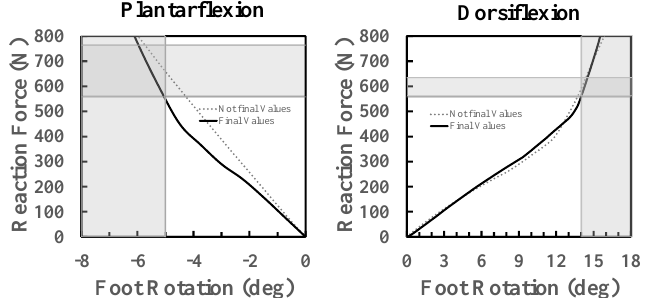
Figure 21. Results from the first stage of the design phase . The results from the pre-optimized configuration (Table 3) are compared to the results of a random configuration. The vertical shadow is the rotation range that the foot must have (values defined and specified in Section 2.4, “Biomechanical Requirements”, i.e., between − 5 degrees and − 8 degrees in the plantarflexion and between 14 degrees and 18 degrees in the dorsiflexion). The horizontal shadow is the range of the ground reaction force (between 95% and 130% in plantarflexion and between 95% and 108% in dorsiflexion of the body weight of the user). The intersection area between the two shadows is the optimal area in which the curve of stiffness of the foot must fall, so that the foot rotates up to the degrees desired when subjected to ground reaction forces.